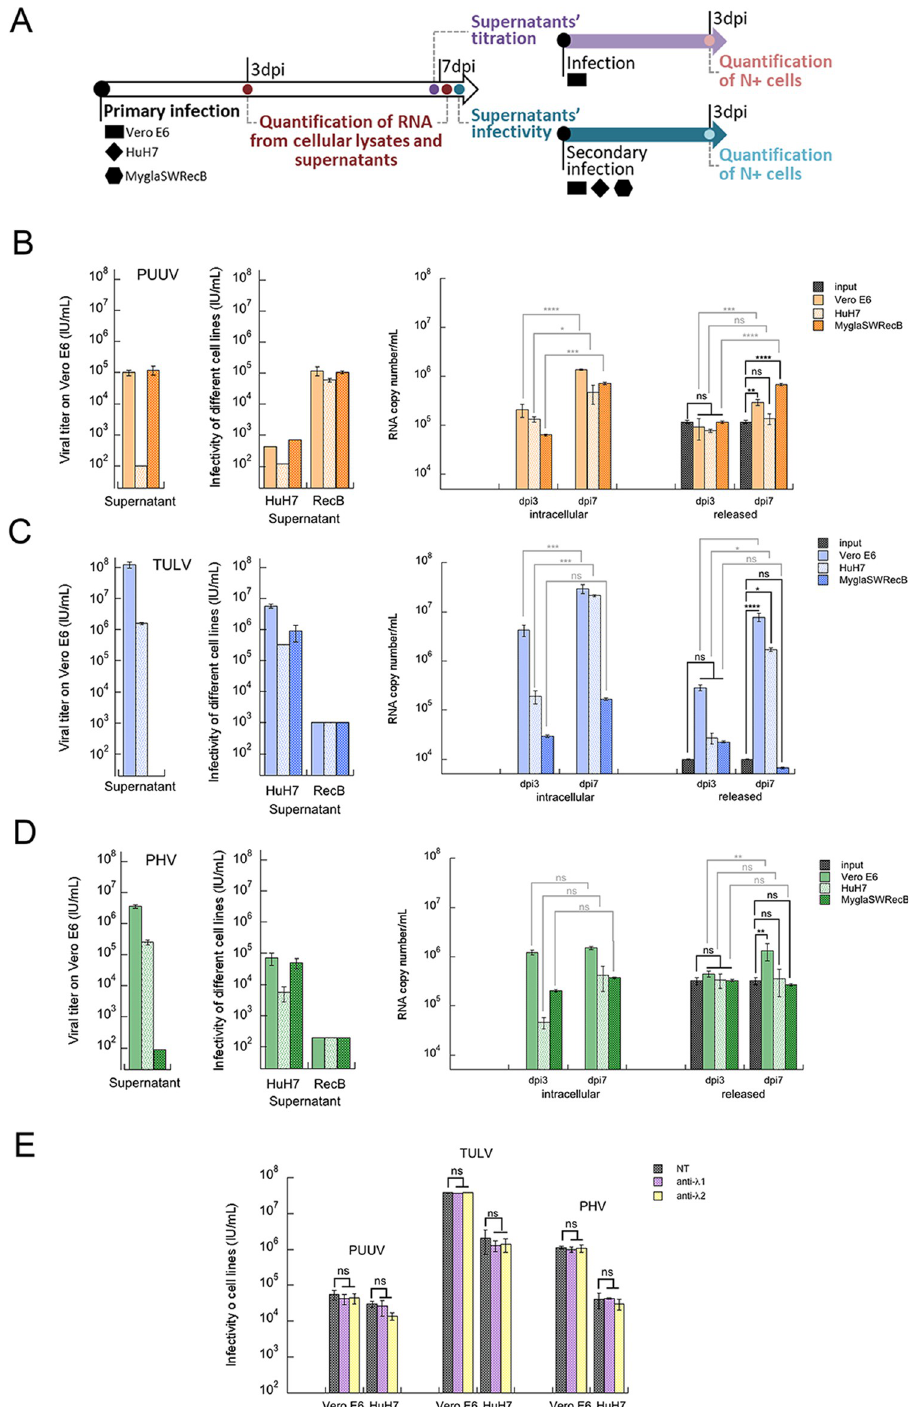
Fig 2. Ability of human and bank vole cells to produce infectious viruses. A schematic representation of the workflow of experiments performed to evaluate the capacity of production of infectious virus by the cell lines further used in the study is shown in (A). Supernatants of Vero E6, HuH7 and MyglaSWRecB cells primarily infected (1 st ) at MOI 0.5 by PUUV (B), TULV (C) or PHV (D) were recovered at dpi 7 for determination of their infectious titers on Vero E6 cells (left panels) and then for their ability to secondary (2 nd ) infect HuH7 and MyglaSWRecB cells (middle panels). Infectious titers were calculated from the percentage of N+ cells determined by immunofluorescence staining at dpi 3 as described in the Materials and Methods section. In parallel, copies of viral RNA produced in the three